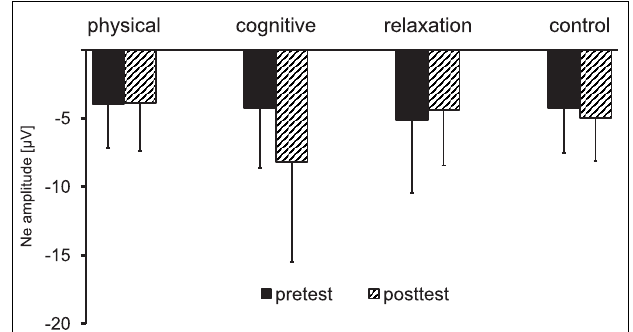
FIGURE 7 | Mean peak amplitude of the error negativity (Ne) collapsed across non-switch and switch trials as a function of session (pre vs. post) and group. The error bars reflect standard deviation